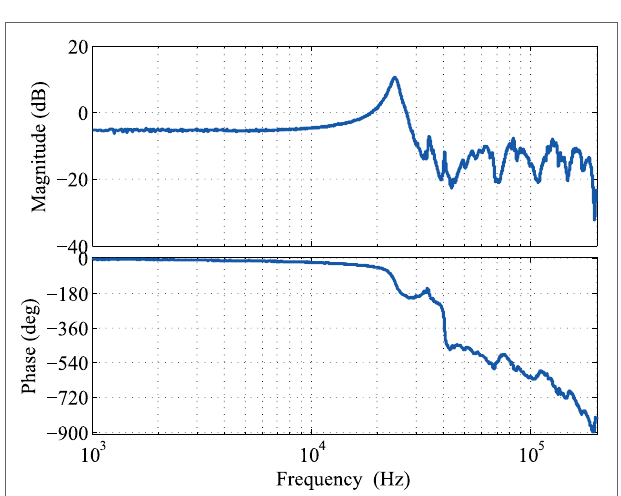
FIGURE 10 | Measured frequency response of the nanopositioning stage (Yong, 2016) .